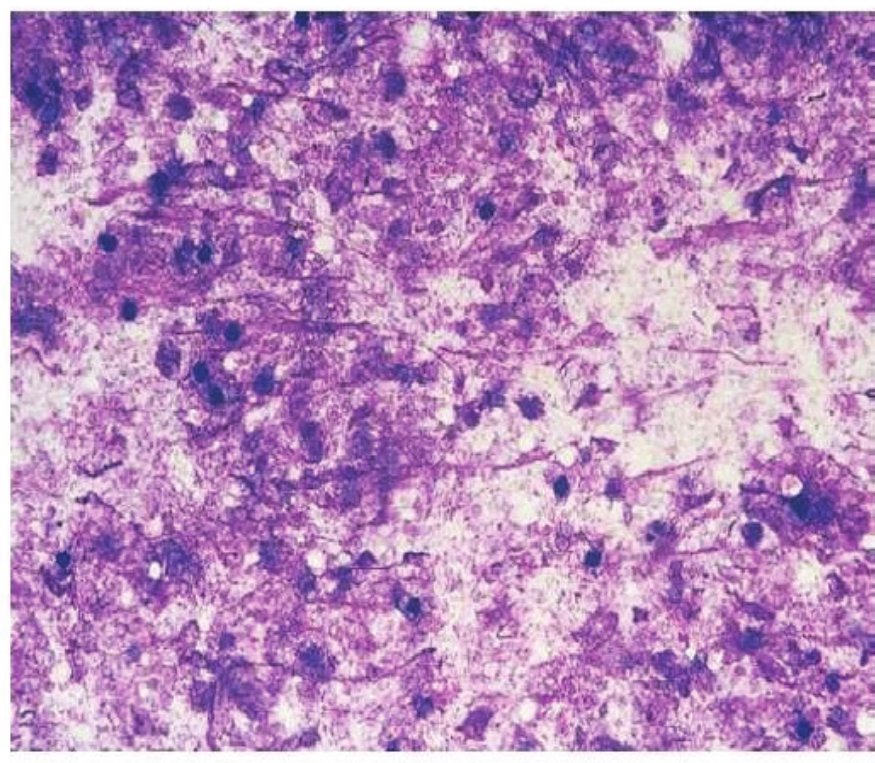
Figure 3 : Tuberculosis lymphadenitis with necrotixing material and a few degenerating nuclei (Romanowsky stain).